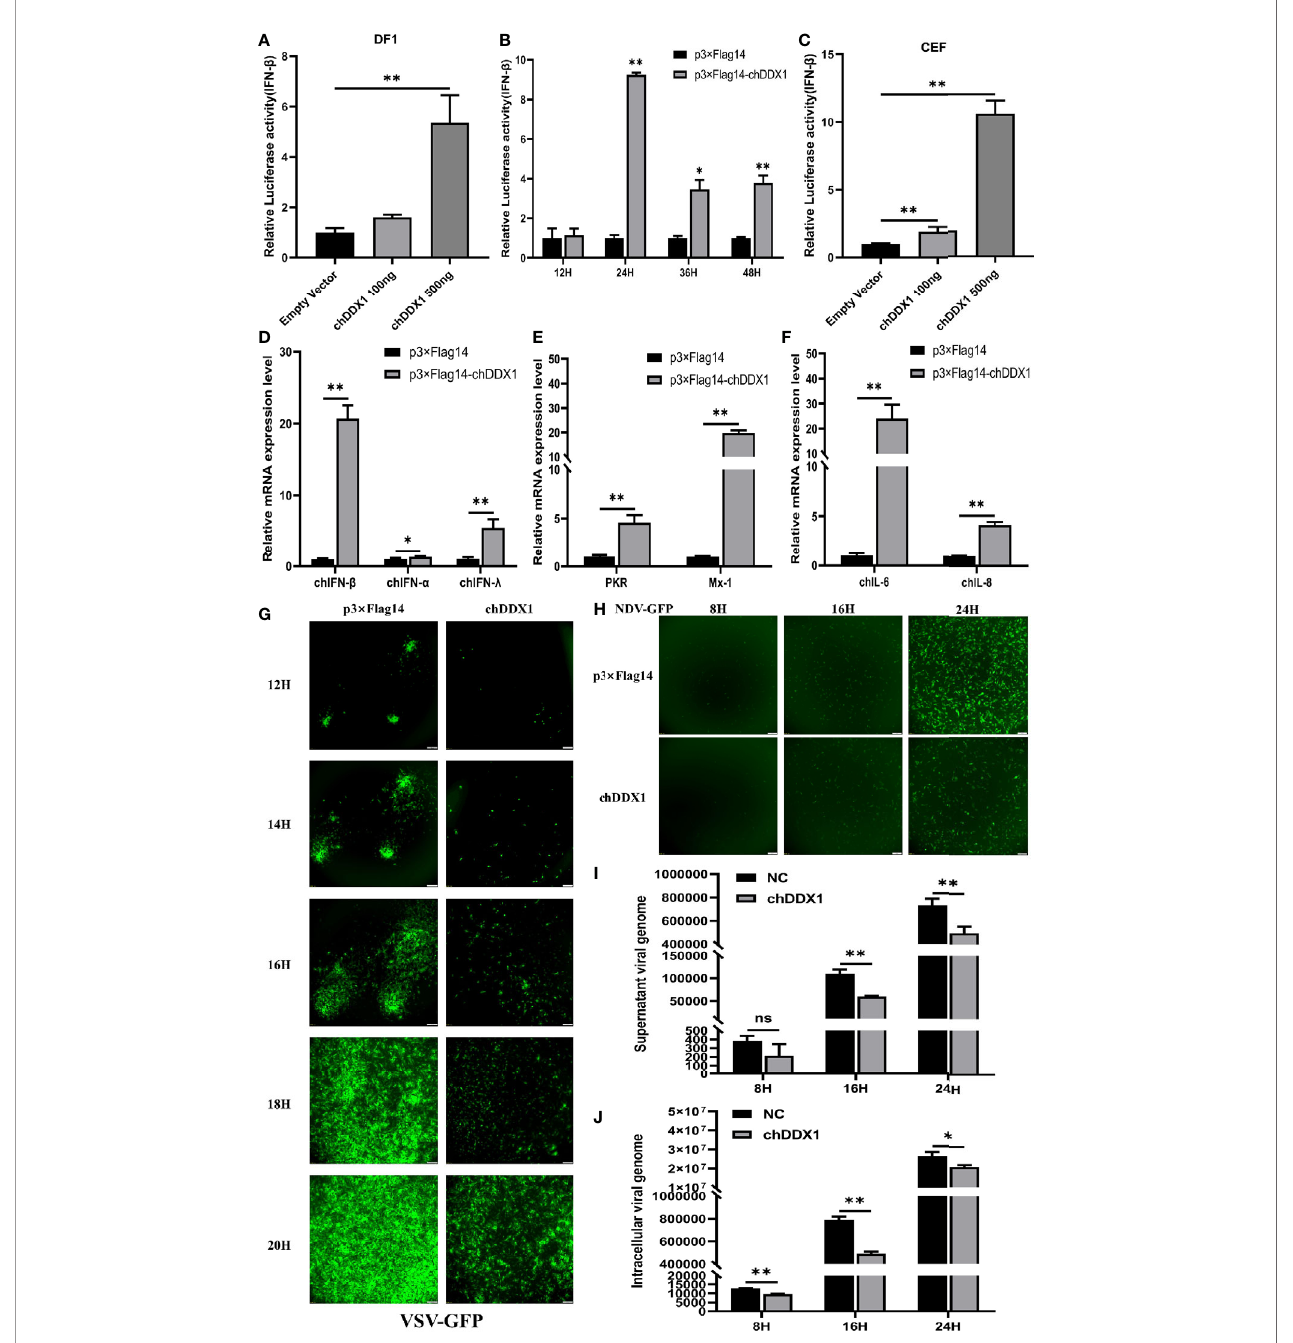
FIGURE 4 | Chicken DDX1 were involved in the regulation of IFNs, pro-in fl ammatory cytokines, and ISGs and also inhibited viral yield. (A) DF-1 cells were co- transfected with luciferase reporter plasmids (pRL-TK and pGL-chIFN- b -Luc) and p3×FLAG-14-chDDX1 or p3×FLAG-14. Luciferase assays were performed after 24 hours of co-transfection. (B) chIFN- b luciferase activity at indicated time points. (C) CEFs were co-transfected with luciferase reporter plasmids and p3×FLAG-14- chDDX1 or p3×FLAG-14. Luciferase assays were performed after 24 hours of co-transfection. (D) Endogenous chIFNs mRNA after transfected with chDDX1 or an empty vector. (E) Relative mRNA levels of ISGs (PKR and Mx-1) after transfection with chDDX1 or an empty vector. (F) Relative mRNA levels of proin fl ammatory cytokines (IL-6 and IL-8) after transfection with chDDX1 or an empty vector. (G) Viral fl uorescence in DF-1 cells transfected with p3×FLAG-14-chDDX1 or p3×FLAG- 14 and infected with VSV-GFP at 0.1 MOI. Error bars represent standard deviations. (H) Viral fl uorescence in DF-1 cells transfected with p3×FLAG-14-chDDX1 or p3×FLAG-14 and infected with NDV-GFP at 0.1 MOI. (I) NSD14 NDV virus genome detected by qRT-PCR in the supernatant of chDDX1-overexpressing DF1 cells at 8, 16 and 24 hours after infection (MOI, 0.1 for 8, 16 and 24 hours). (J) NSD14 NDV virus genome detected by qRT-PCR in chDDX1-overexpressing DF1 cells (MOI, 0.1 for 8, 16 and 24 hours). The difference between the experimental and control groups was * p < 0.05 or ** p <